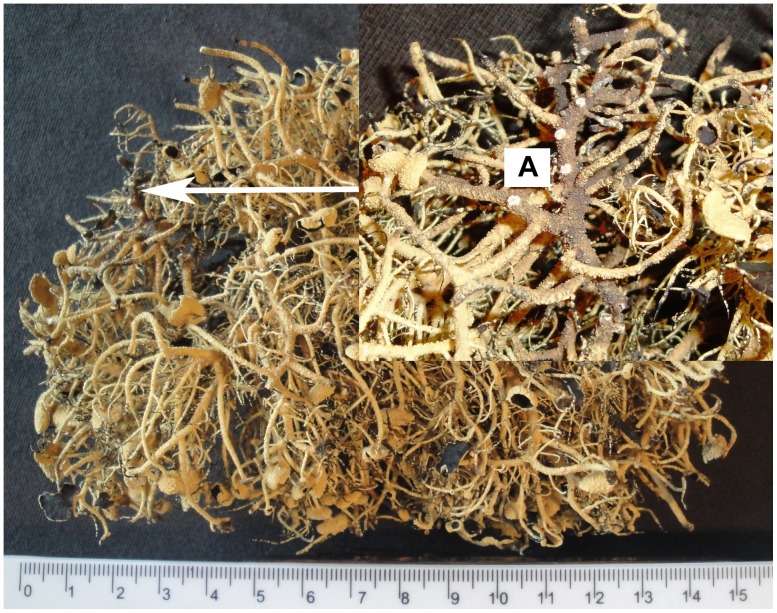
The upper part of U. aurantiacoatra, the part which was taken as Sample A.